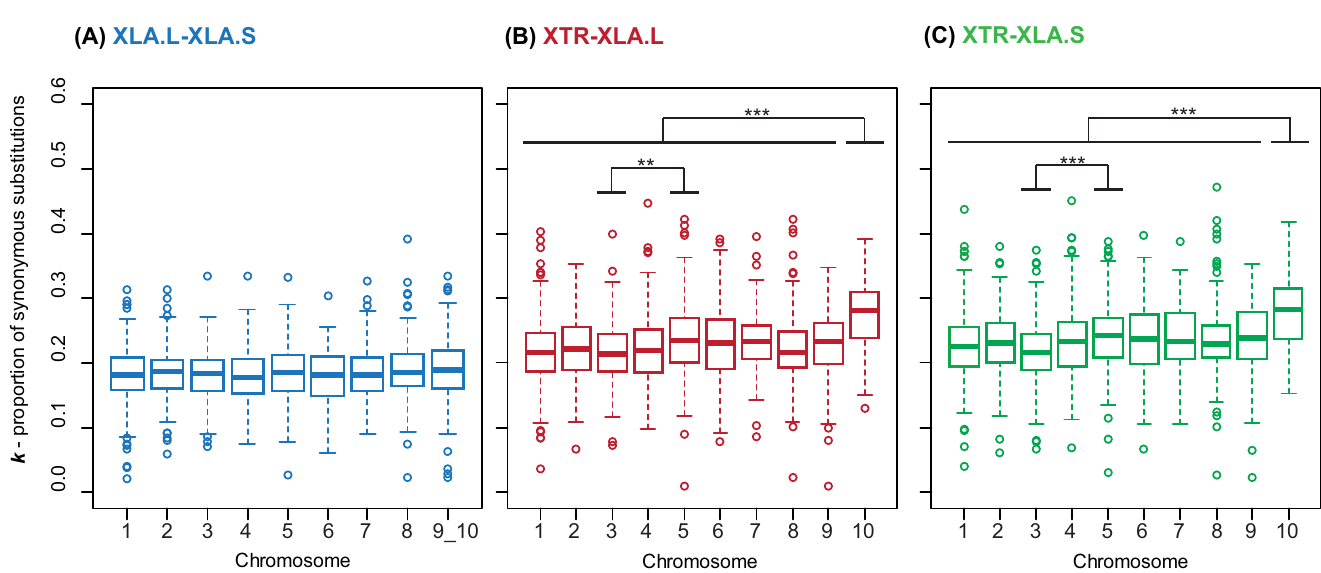
Fig 1. Boxplots depicting proportion of synonymous substitutions ( k ) for each chromosome. Between (A) X . laevis L (XLA.L) and S (XLA.S) sub-genomes, (B) X . tropicalis (XTR) and XLA.L, and (C) XTR and XLA.S. �� p < 0.01, ��� p < 0.0001 (adjusted p-values from Tukey multiple comparisons of means).